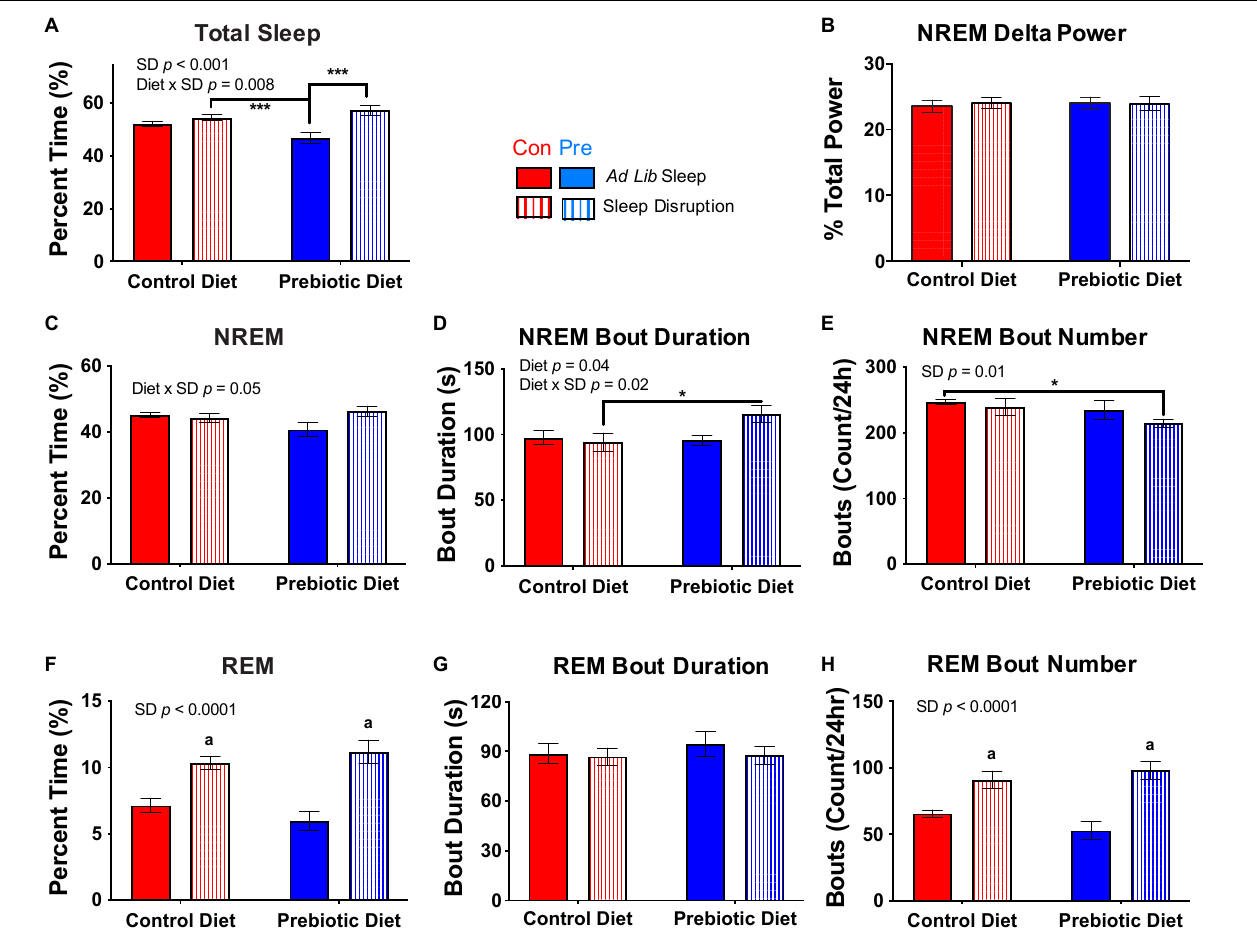
FIGURE 5 | The prebiotic diet improves recovery sleep post-sleep disruption. Twenty-four hours of ad libitum sleep was recorded after the completion of the 5-day sleep disruption protocol. (A) Total sleep, (B) NREM EEG delta power, (C) NREM sleep, (D) median NREM bout duration, (E) number of NREM bouts over 24 h, (F) REM sleep, (G) median REM bout duration, and (H) number of REM bouts over 24 h are depicted above for the control ( ad libitum sleep throughout) and sleep-disrupted (with no social defeat) groups. Aligned rank transform ANOVA testing for an effect of diet, sleep disruption, and interaction was performed for each measure, and significant or near significant results are reported in the figure. Data are mean + SEM. Symbols: *** p < 0.001, * p < 0.05, Bonferroni’s post hoc test. a p < 0.001 vs both control diet, ad libitum sleep and prebiotic diet, ad libitum sleep groups, Bonferroni’s post hoc test. Con, control diet; NREM, non-rapid eye movement sleep; Pre, prebiotic diet; REM, rapid eye movement sleep; SD, sleep disruption. n =